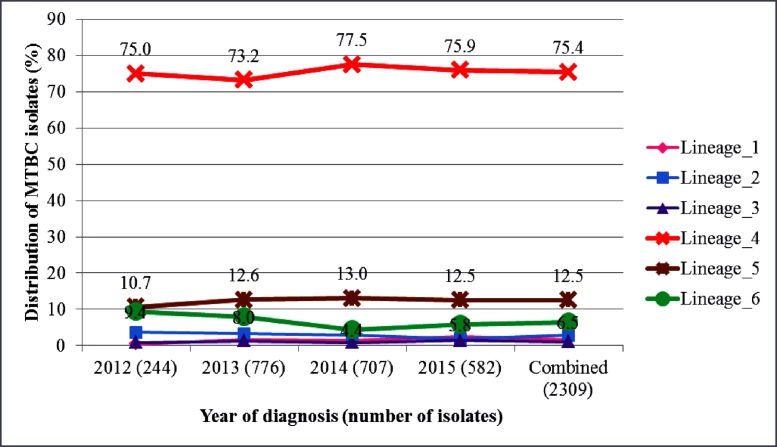
Temporal distribution of 2309 Mycobacterium tuberculosis complex (MTBC) isolates stratified by lineage. Lineages are color-coded with the universally accepted color codes for the main MTBC lineages.